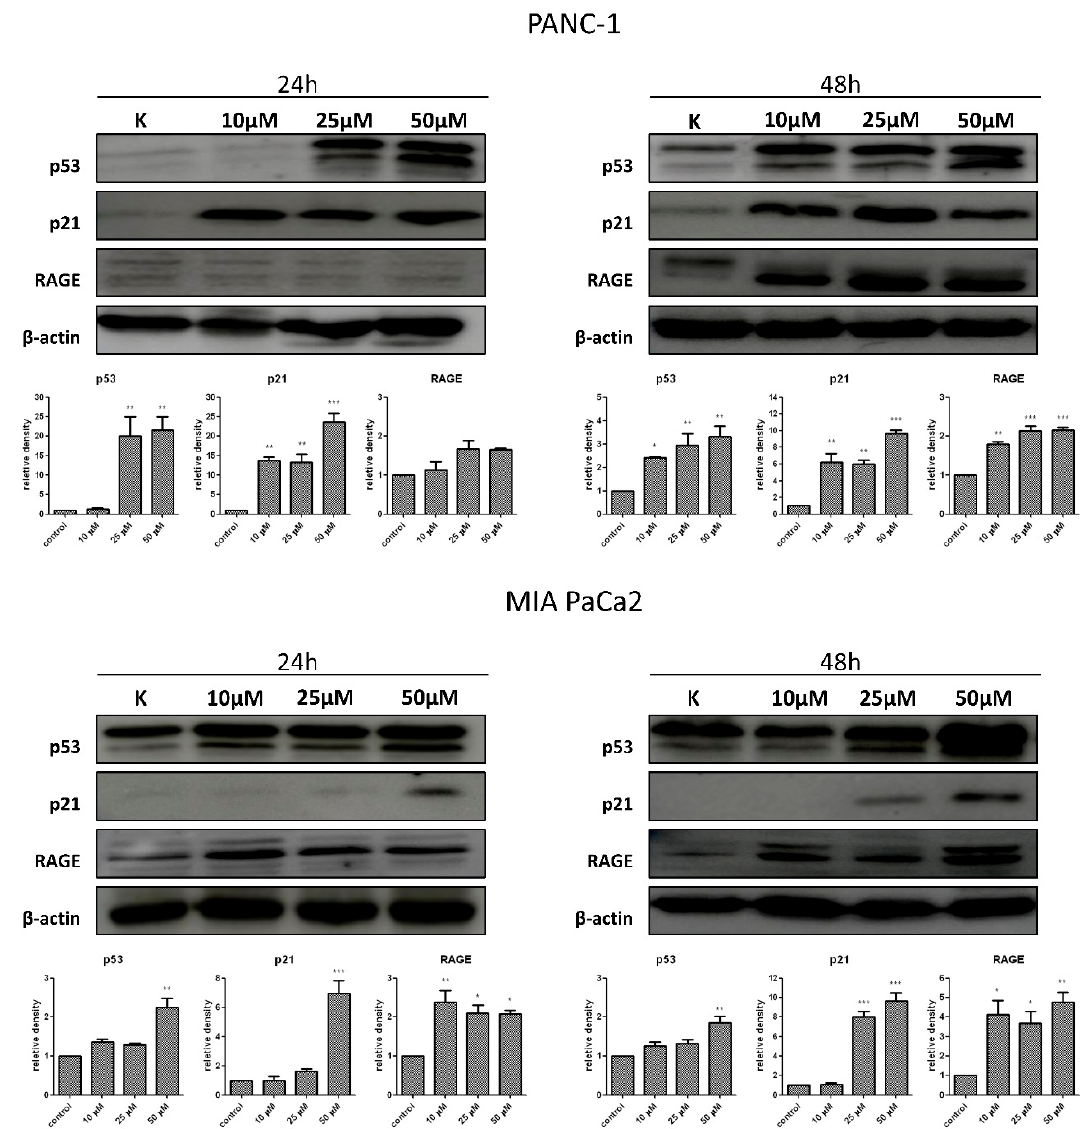
Figure 8. Expression of p53, p21 and RAGE in T1-treated cancer cells as measured by Western blot. β -actin was used as internal control. Data are mean ± SD of 3 separate determinations. * p < 0.1; ** p < 0.01; *** p < 0.001, as compared with untreated cells.